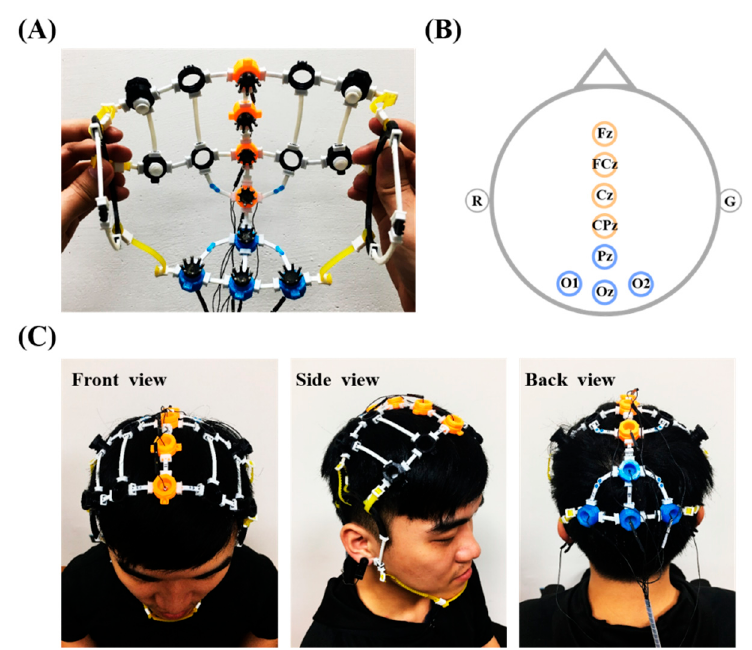
Figure 2. Implementation of an 8-electrode holder assembly grid. ( A ) Assembled headset embedded with Cognionics dry electrodes; ( B ) 8-channel montage; ( C ) headset wore on the head at different view angles.